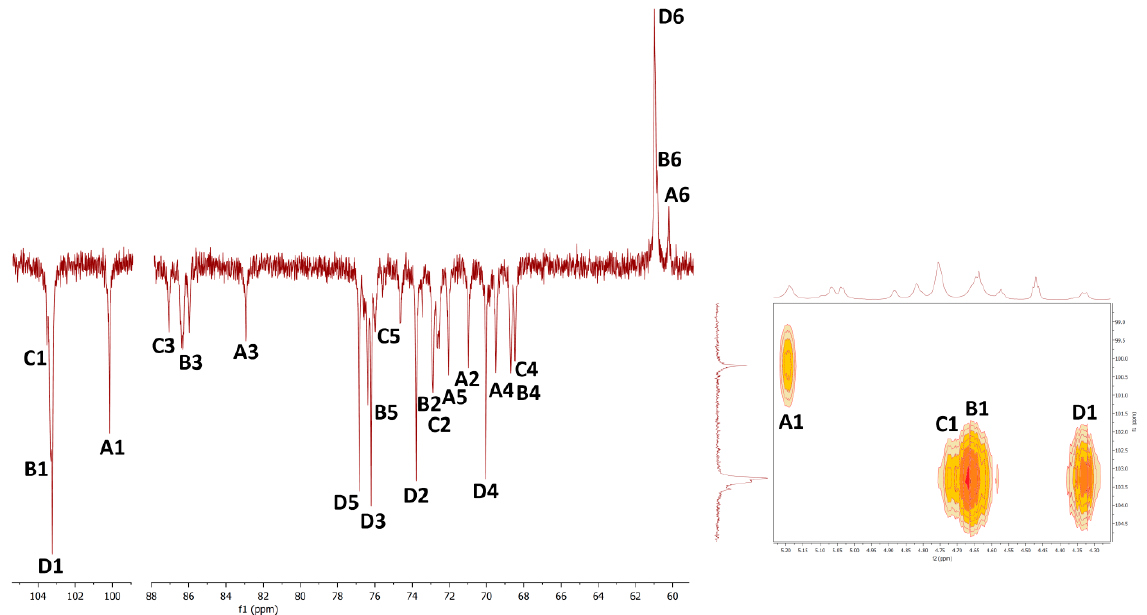
Figure 5. Carbon-13 APT NMR (left) and 1 H, 13 C HMQC (right) spectra of sub-fraction F3a.